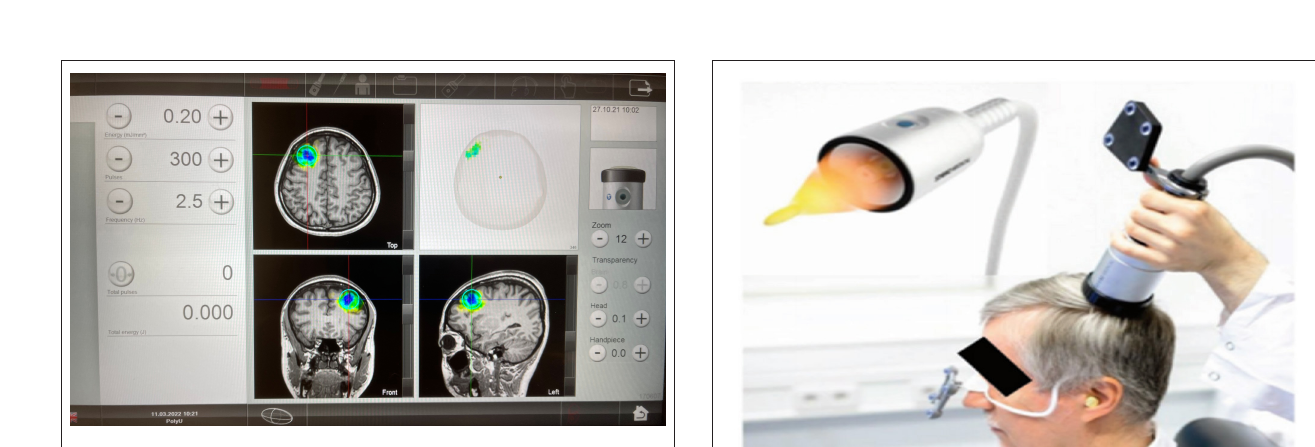
FIGURE 2 | Post TPS stimulation images.